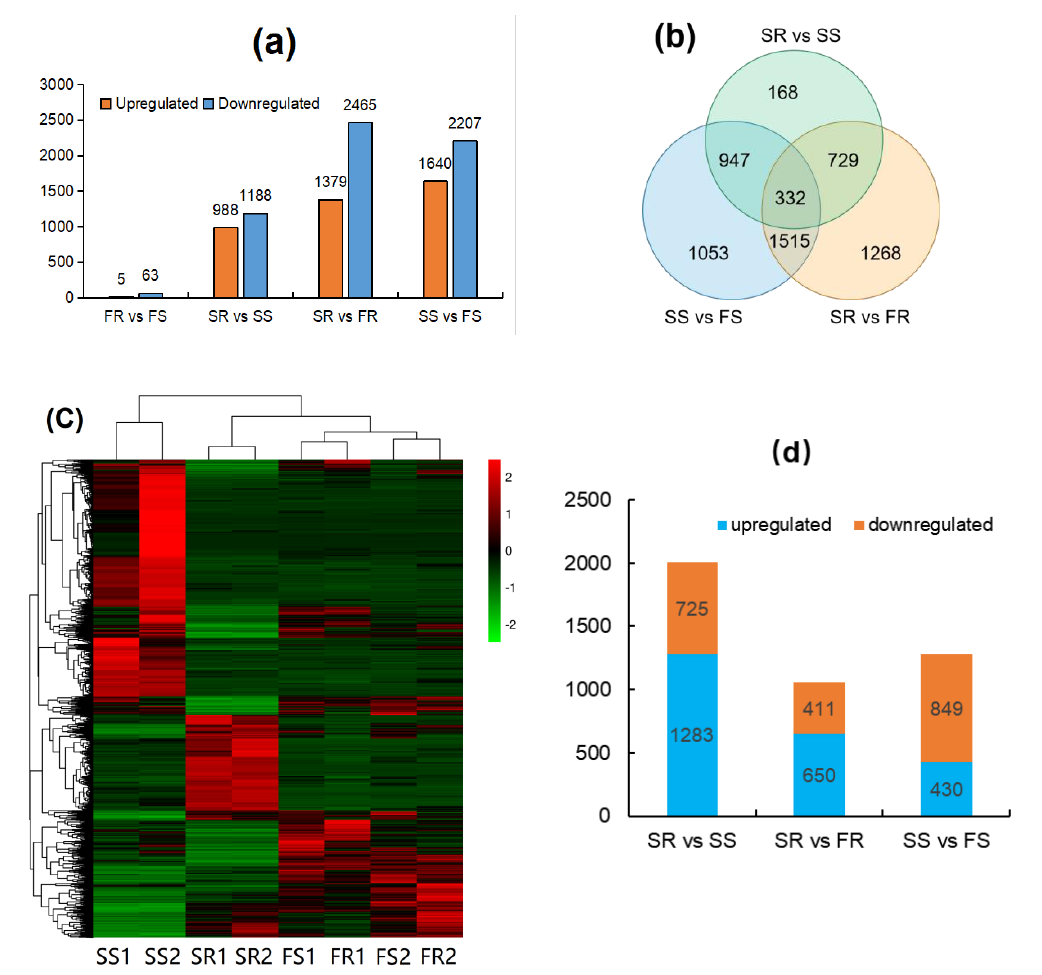
Figure 4. Differentially expressed gene analysis of FR, SR, FS and SS. ( a ) DEGs in statistics for FR vs. FS, SR vs. SS, SS vs. FS and SR vs. FR. The ordinate value represents the number of DEG. ( b ) Venn diagram depicting co-expressed and specific expressed DEGs in the pairwise comparisons: SR vs. SS, SS vs. FS and SR vs. FR. ( c ) Heatmap of the selected 2008 (322, 947 and 729) common DEGs. The color scale represents Z-score. ( d ) The upregulated and downregulated genes in the 2008 common DEGs. The ordinate value represents the number of co-DEG.